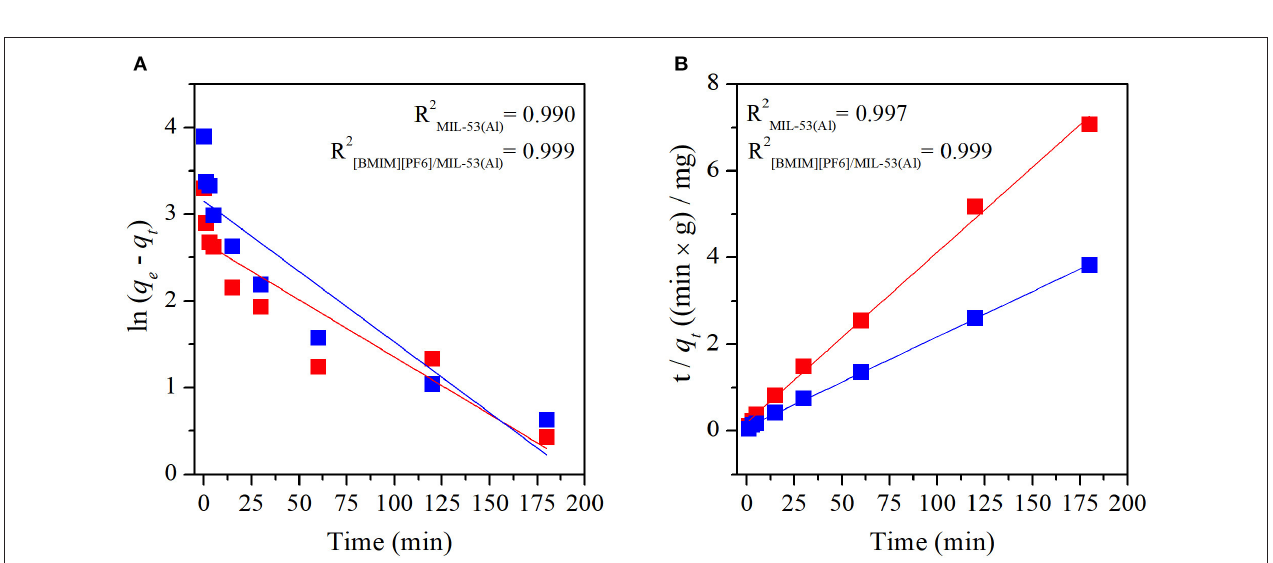
FIGURE 4 | Plots of (A) pseudo-first-order and (B) pseudo-second-order kinetics of MO adsorption on MIL-53(Al) (red), and [BMIM][PF 6 ]/MIL-53(Al) (blue). MO, methyl